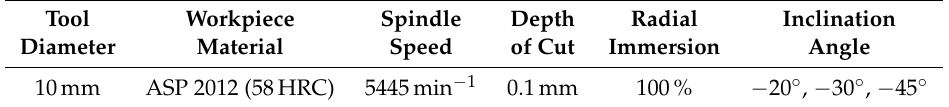
Table 2. Process parameter values.